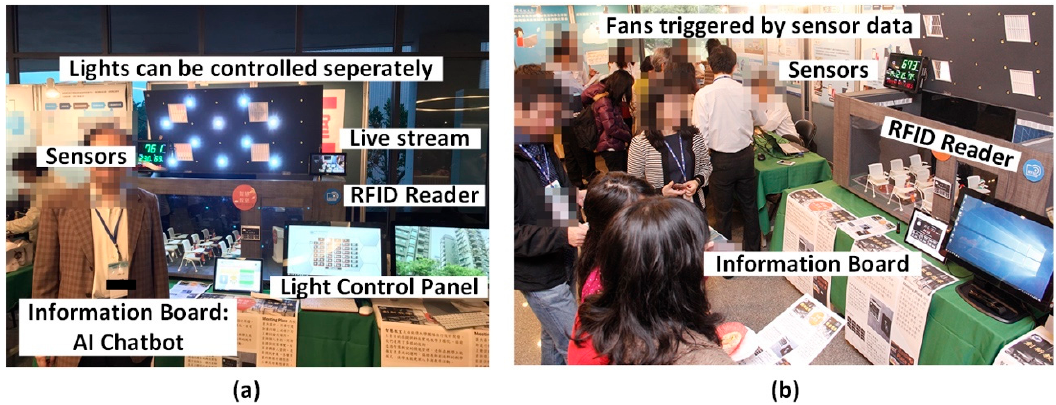
Figure 17. Smart classroom model house demonstration in International Conference on Smart Campus and Exhibition 2018. Most smart classroom functions are re-implemented with Raspberry Pi, Python, and PHP: ( a ). Lights can be controlled separately with a mobile phone and control panel. A camera toward the whiteboard is live streaming real-time classroom situation; ( b ) context-aware functions are also implemented, fans on the model house are triggered by CO 2 levels. The RFID reader is used to control the door lock of the model house.